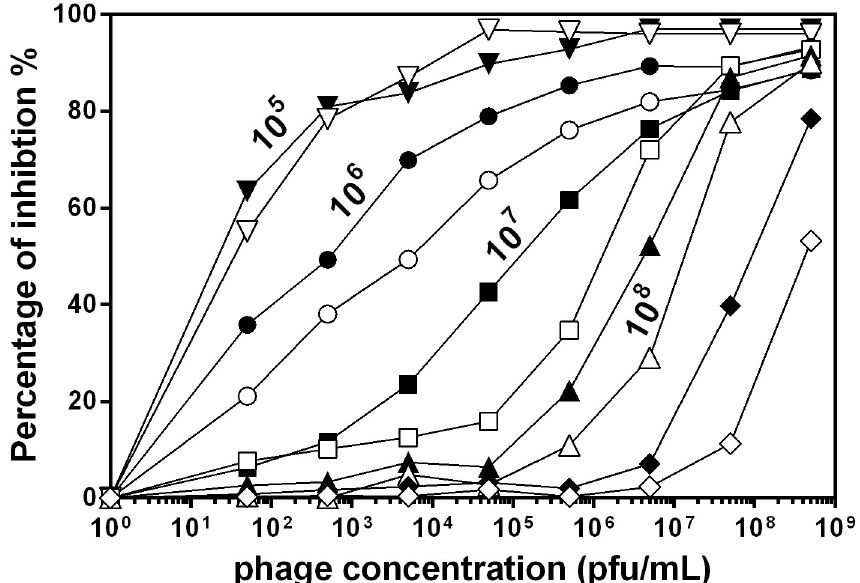
Fig 5. Percentage of inhibition as a function of phage concentration for different values of cell concentration. 5x108 ( ◇ ), 2.5x10 8 ( ◆ ), 10 8 ( 4 ), 5x10 7 ( ▲ ), 2.5x10 7 ( □ ), 10 7 ( ■ ), 5x10 6 ( � ), 10 6 ( ● ), 5x10 5 ( 5 ), 10 5 cfu/ml ( ▼ ). Percentages of inhibition were calculated as described in Materials and